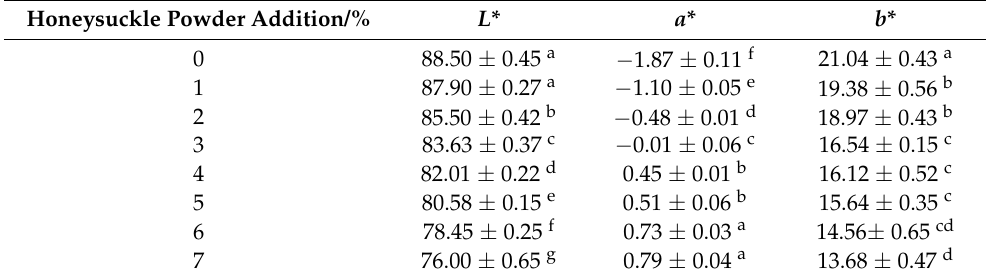
Different lowercase letters in the same column indicate a significant difference ( p < 0.05), while the same lowercase letters indicate no significant difference ( p > 0.05).